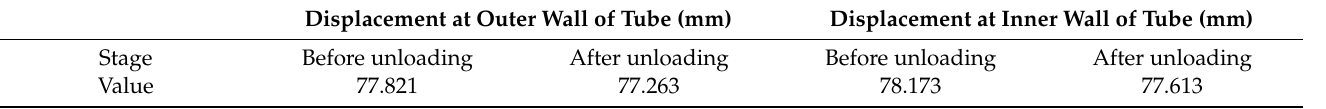
Table 1. Displacements at wave height before and after